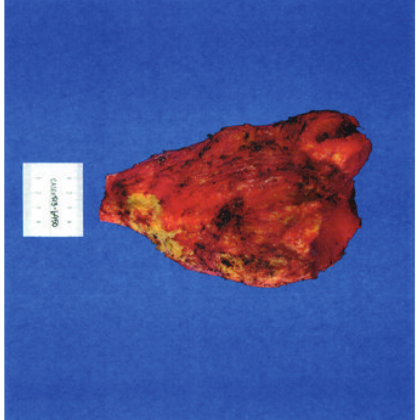
Figure 2: MRI showing 12.0 × 12.1 × 14.3 cm multilobulated soft tissue mass.